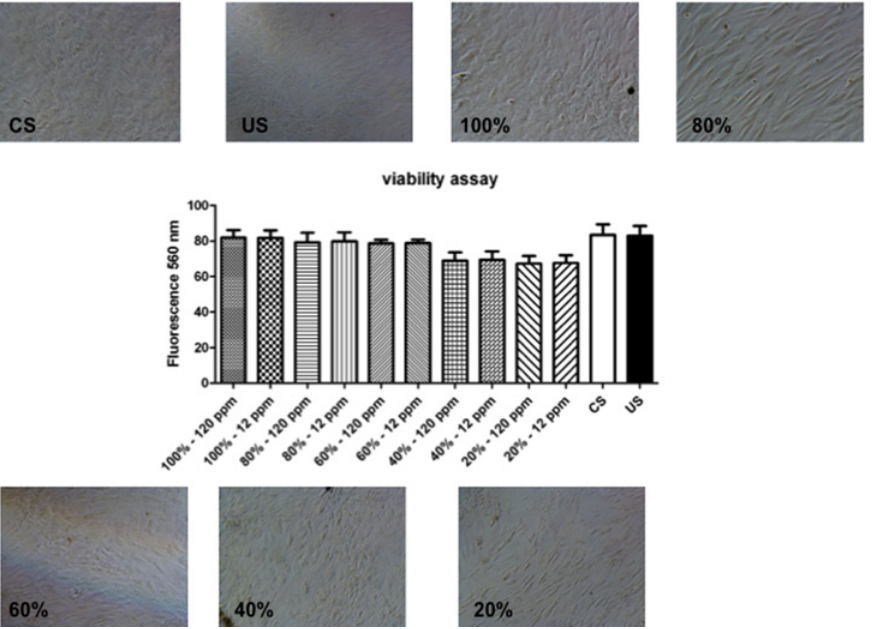
Figure 2. Effect of hemofiltrates on viability and osteogenic differentiation of hMCSs. PrestoBlue assay on cells treated with the five different hemofiltration fractions (20%, 40%, 60%, 80% and 100%), at a final concentrations of 120 or 12 ppm, still ensured suitable cell viability, compared to cell treated with serum from healthy donors (control serum; CS) and serum from uremic patients (uremic serum; US), in normal medium (bar plot). Photomicroscopy images of hMSCs treated with CS, US or in the presence of the five indicated hemofiltrate fractions are also shown.